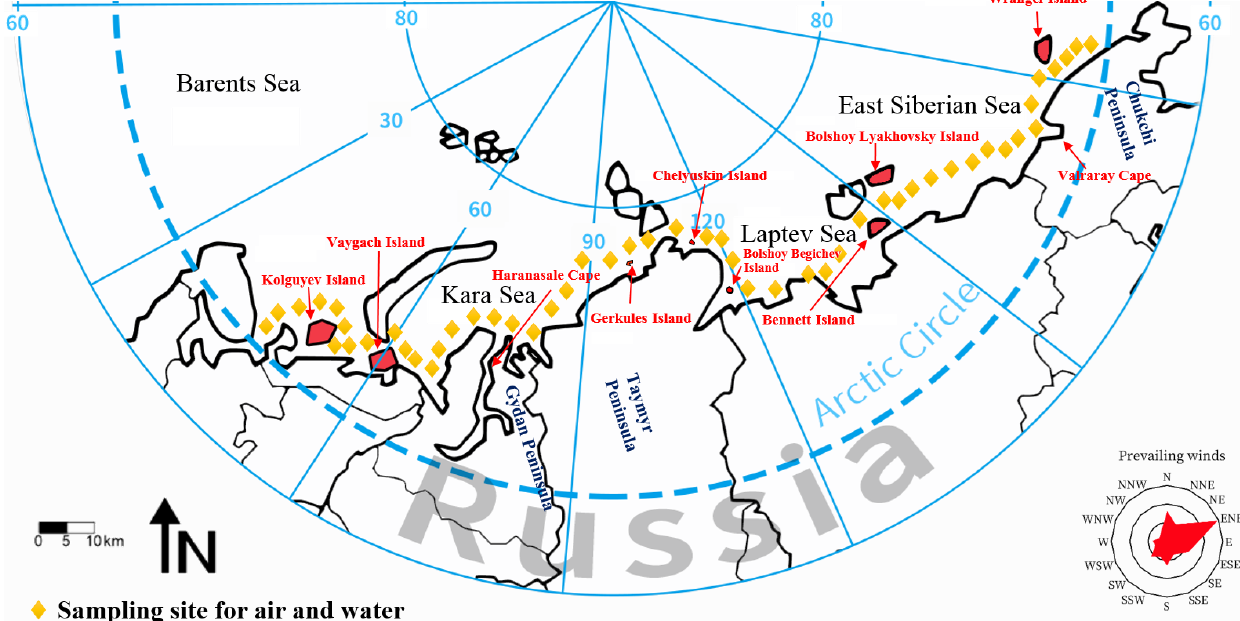
Figure 1. Locations of investigated islands for soil sampling and trajectory of the vessel in the Russian